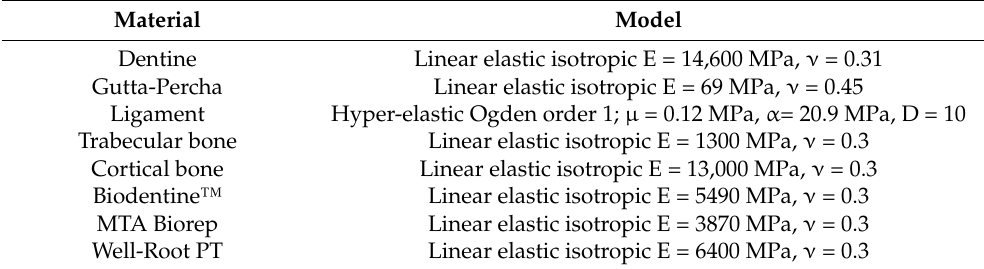
Table 1. Material properties used for FEA analysis [15].